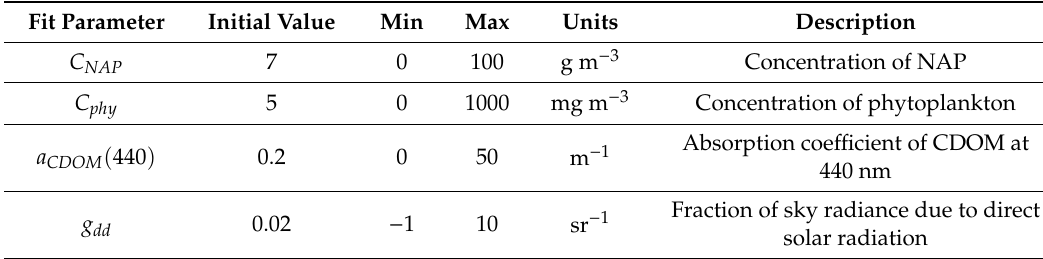
Table 2. Fit parameters and associated initial values for water quality inversion using Water Color Simulator